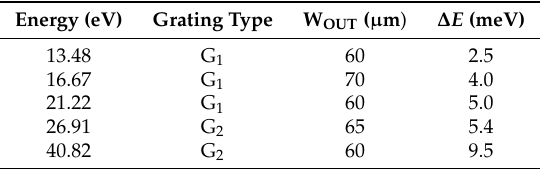
Table 2. Widths of the spectral lines measured on the exit slit plane.